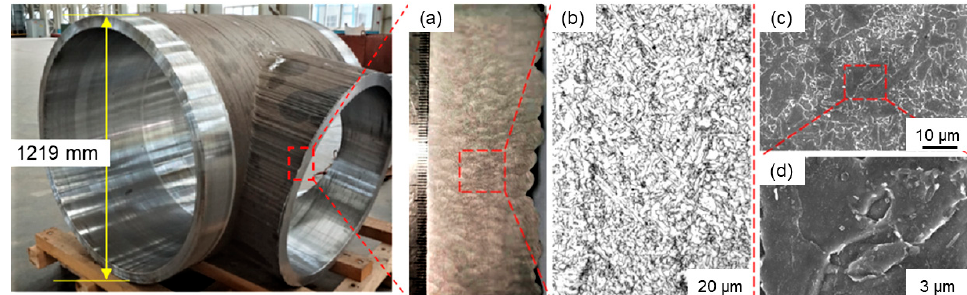
Figure 5. Microstructures in deposits of the SAAM workpieces. ( a ) Macro metallographic picture ( b ) Metallographic picture ( c ) Scanning electron microscope image ( d ) Local scanning electron microscope image.